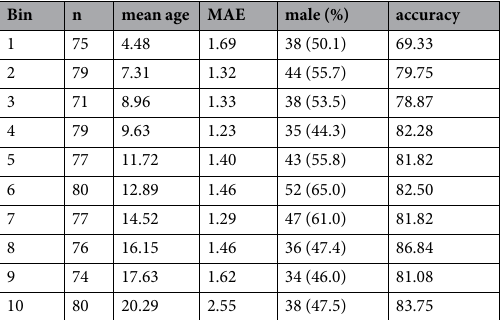
Table 1. Age and sex prediction accuracy at different ages.